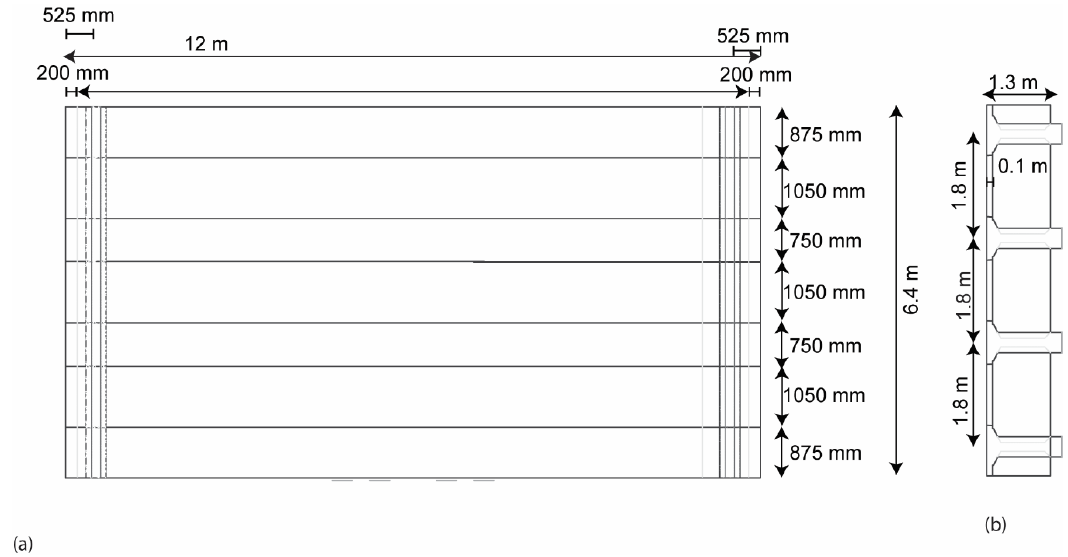
Figure 3. Dimensions of first 1:2 scale model: ( a ) top view; ( b ) cross-section view. Figure adapted from Reference [34]. Reprinted with permission. This figure was originally published in Vol. 116 of the ACI Structural Journal.